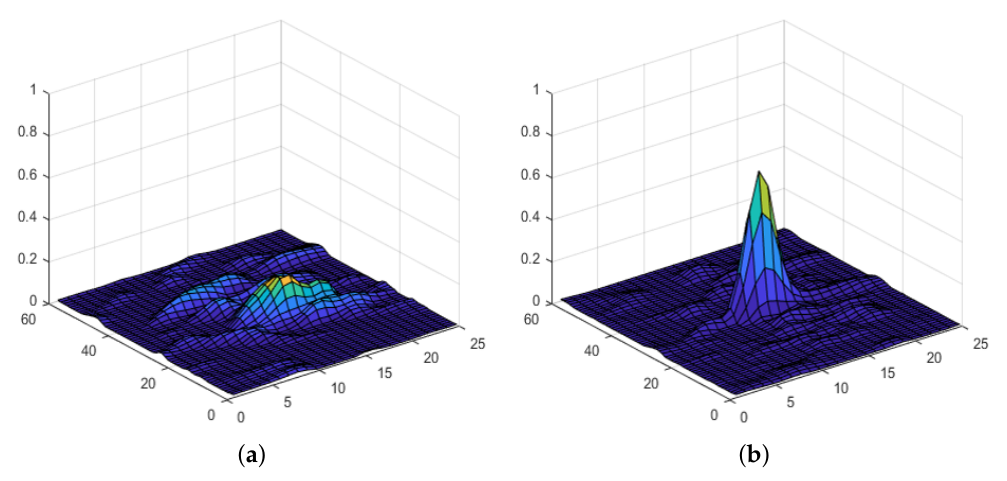
Figure 4. The adaptive learning rate according to response. ( a ) response map with learning rate value of 0.0055; ( b ) response map with learning rate value of